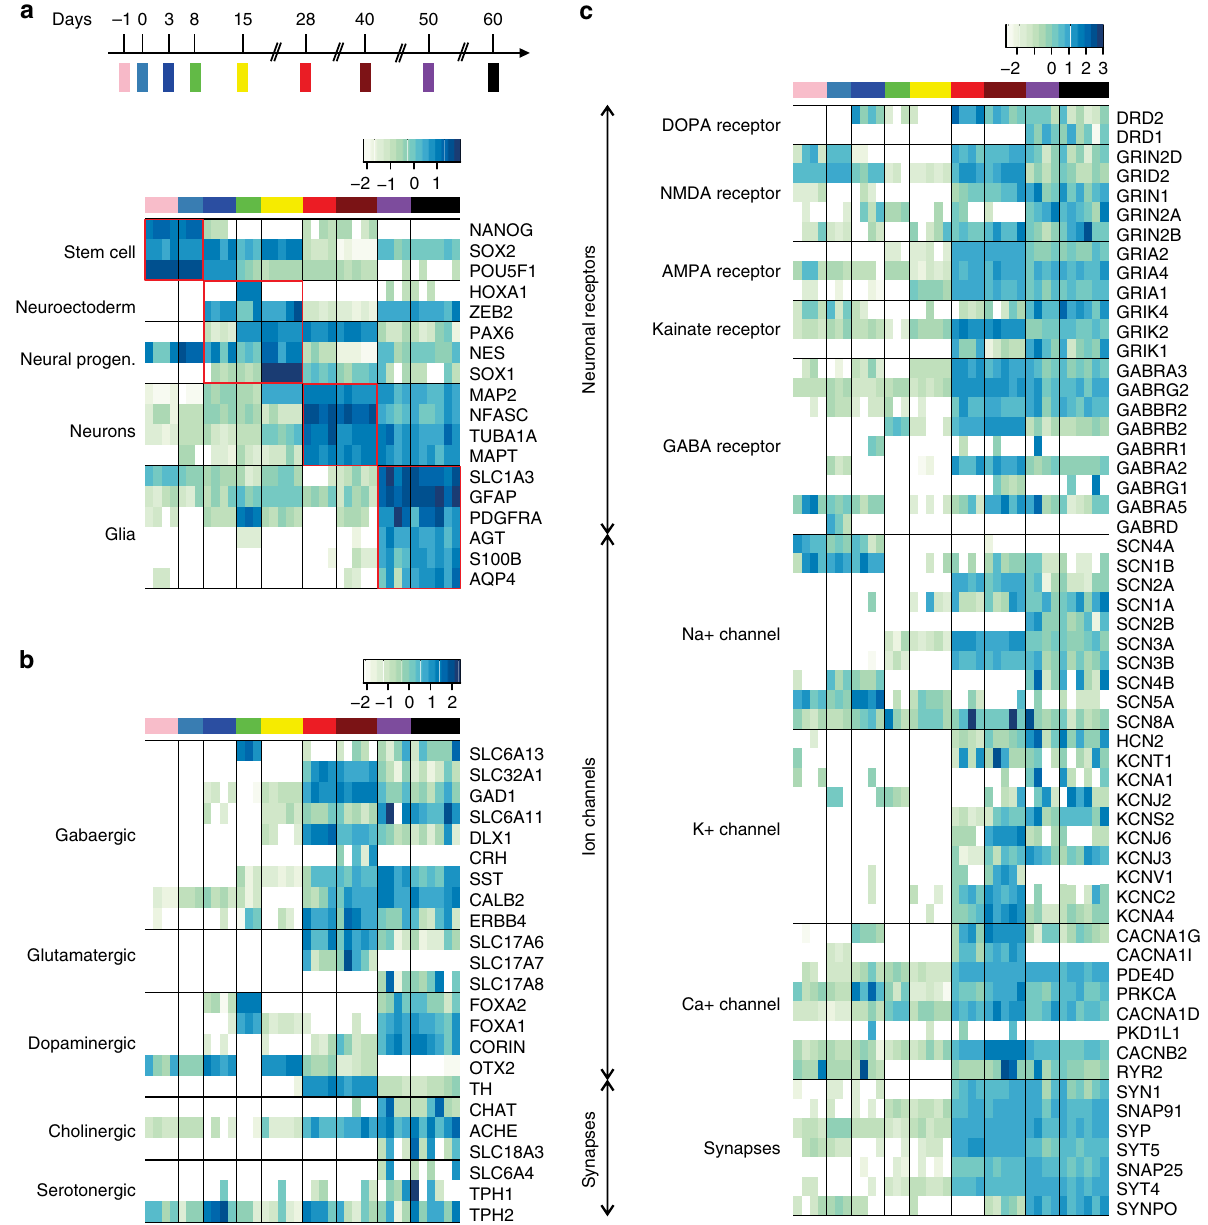
Fig. 2 Transcriptome analyses during BENO generation (from d-1 to d60) by RNA sequencing. a Heat map showing distinct developmental stages: d-1 to d0 — pluripotent stem cell stage; d3 – d8 — neuroectodermal commitment stage; d8 – d15 — NPC stage; d15 – d40 — neurogenesis; d40 and onwards — neuronal maturation with concurrent gliogenesis. b Increase of the abundance of transcripts encoding for GABAergic, glutamatergic, dopaminergic, cholinergic, and serotonergic proteins from d28 onwards. c Heat map depicting the expression of transcripts encoding for proteins involved in synaptic transmission, including postsynaptic receptors, ion channels, and synaptic